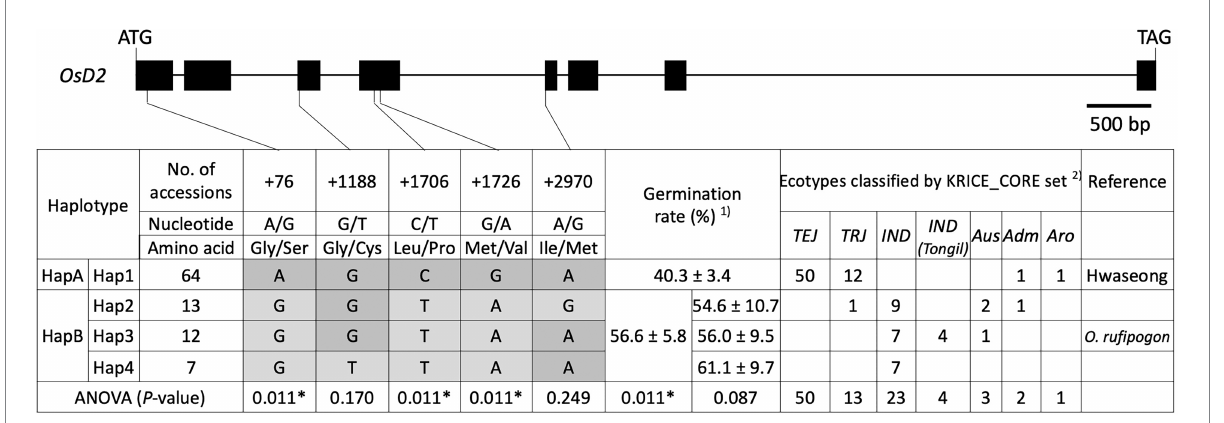
FIGURE 5 Haplotype analysis of OsD2 using 96 rice accessions from the KRICE_CORE set. 1) Germination rate was presented as mean ± SE. 2) TEJ , temperate japonica ; TRJ , tropical japonica ; IND , indica ; IND (Tongil), indica Tongil; Aus , Aus; Adm , admixture; and Aro , aromatic. * indicates significant difference at p < 0.05 based on one-way